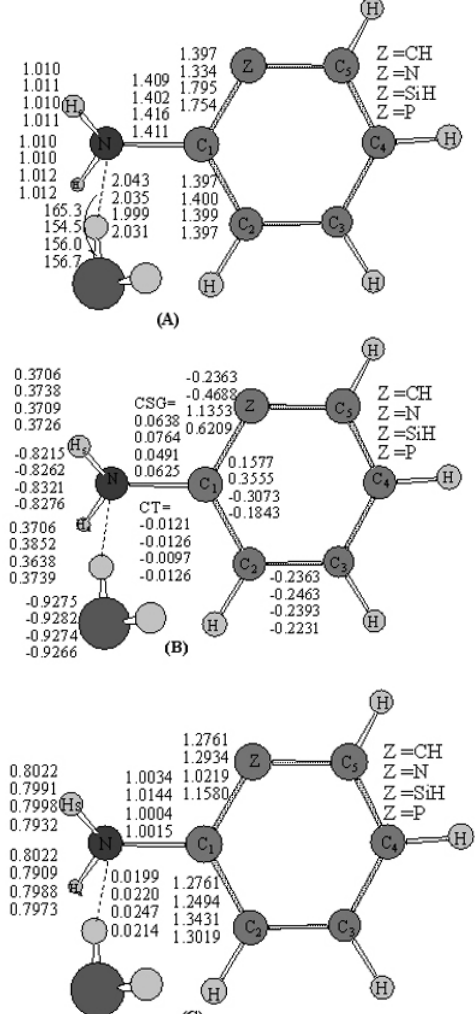
Figure 7. (A) MP2/cc-pVTZ optimized geometries of FAY(1)-HA (X= C, N, Si, and P) complexes, with the bond lengths in angstroms. (B) MP2/6-311++G**//MP2/cc-pVTZ natural charges (in e) of partial charges, and the charge transfer (CT) from NH + H O groups (CSG). (C) MP2/6-311++G**// 2 2 MP2/cc-pVTZ